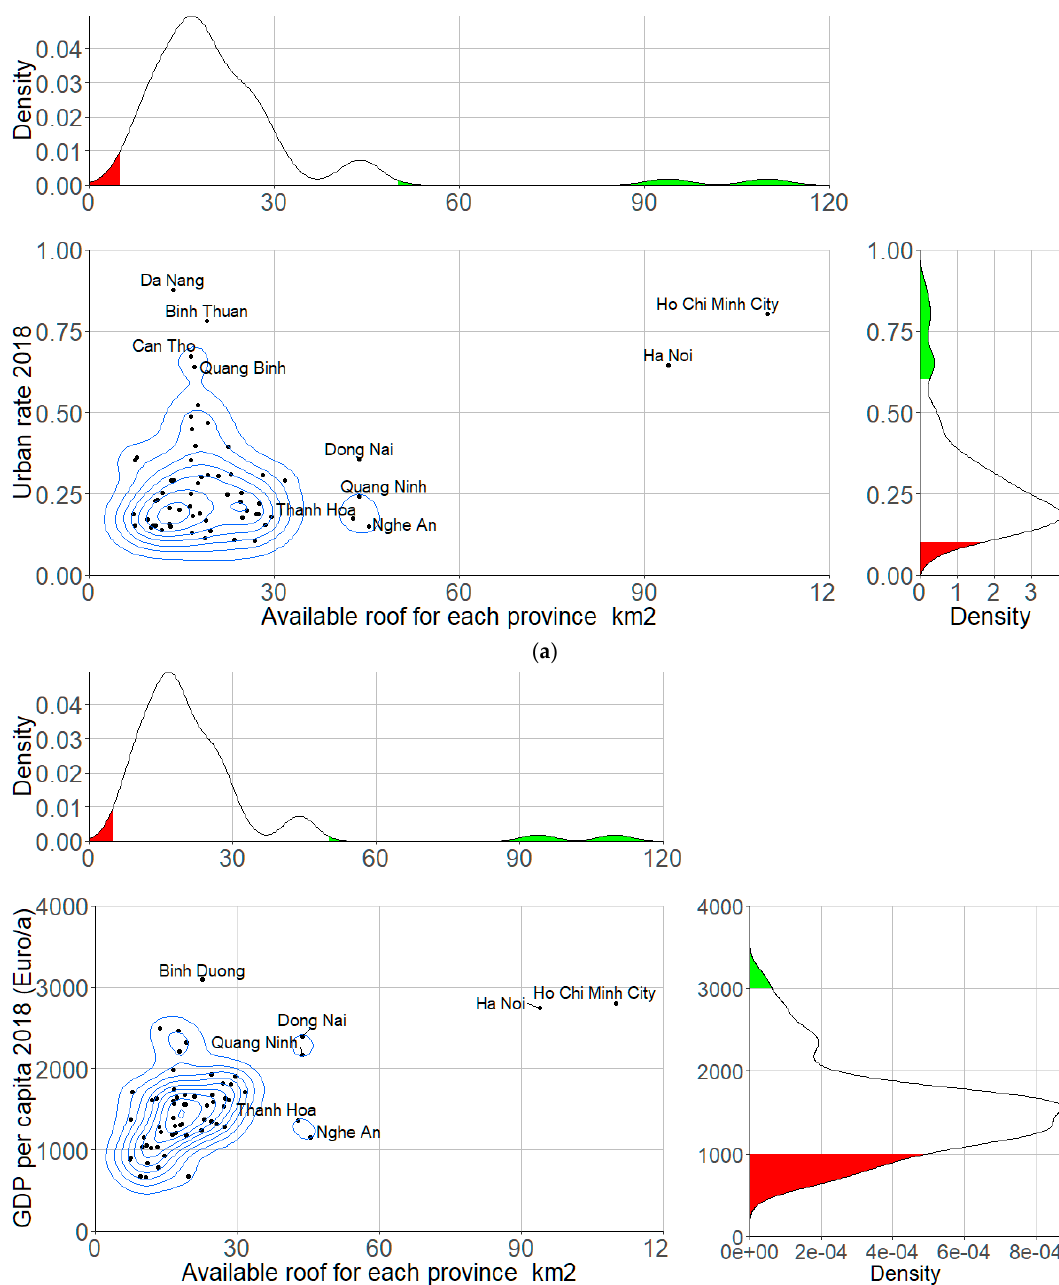
Figure 11. Rooftop PV potential distribution corresponding to the level of urbanization ( a ) and income per capita ( b ) [46] in 63 provinces in Vietnam.